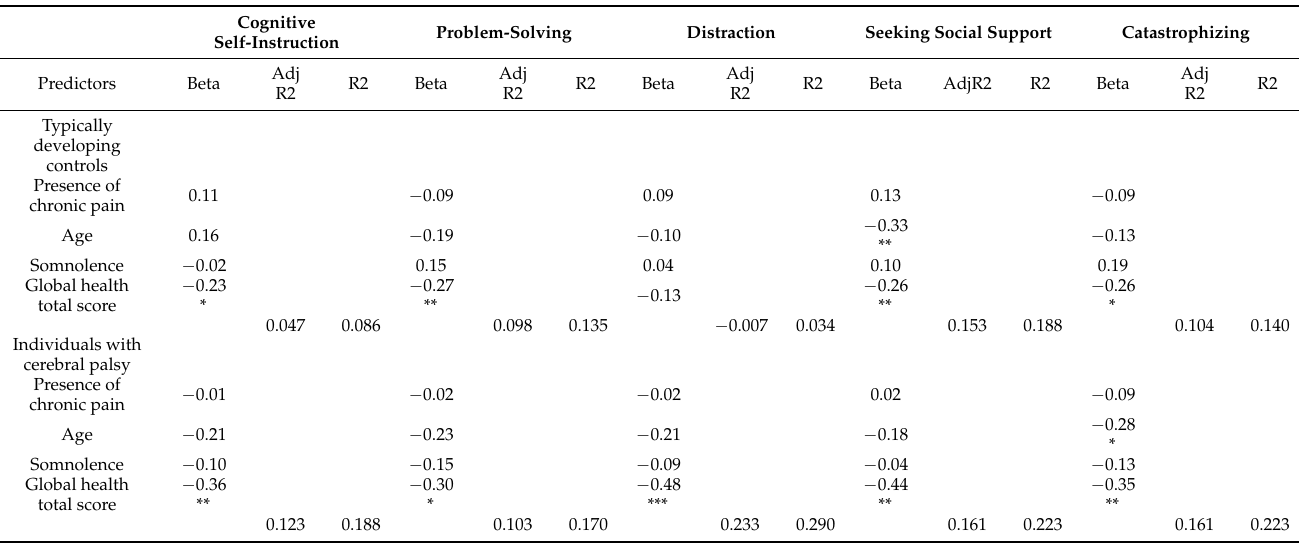
Table 4. Multiple regression predictors of pain-coping strategies in individuals with cerebral palsy and controls with typical development.